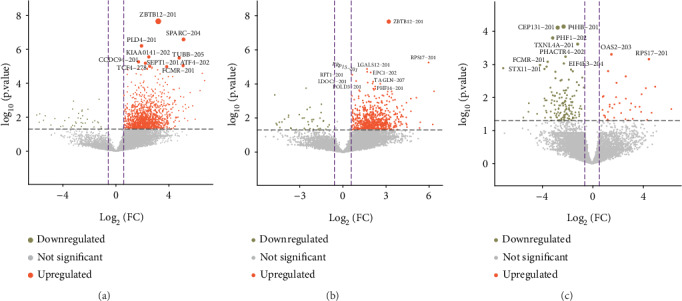
The volcano plots of the differentially expressed mRNAs identified between different groups. (a) Type 1 vs. type 2. (b) Type 1 vs. type 3. (c) Type 2 vs. type 3. Downregulated (khaki) and upregulated (orange red) mRNAs are indicated. mRNAs found to be not significantly altered between the groups are displayed in gray. FC: fold change. The top 10 mRNAs according to their P value ranking are listed. The circle size is proportional to the P value.